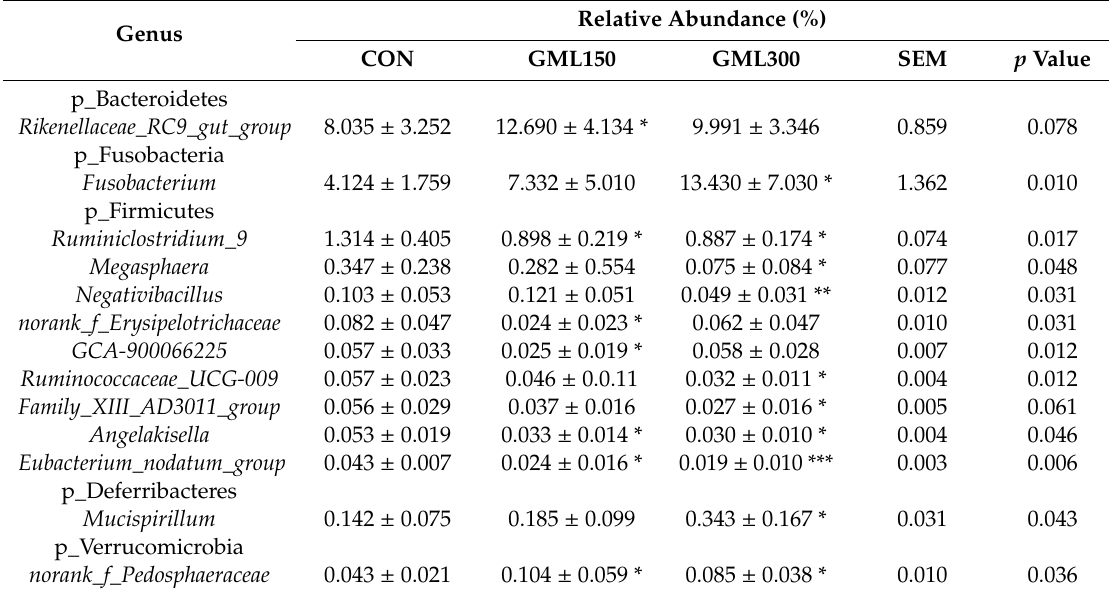
Data are expressed as means ± SD ( n = 7). Asterisk indicates significantly di ff erences according to the Kruskal–Wallis test (* p < 0.05, ** p < 0.01, *** p <